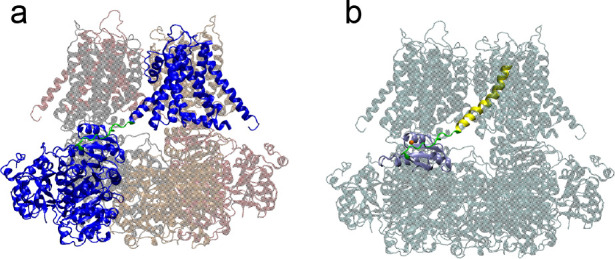
Structural properties of BK channels.(a) Domain swapping arrangement of BK channels. Shown is the structure of the human BK channels (hSlo1) with chain A colored blue and C-linker colored green. Other domains are made transparent for clarity. (b) The C-linker (green) directly connects the pore lining helix (S6, yellow) to the RCK1 N-lobe (blue) of the CTD. The bound Mg2+ is shown as an orange sphere.